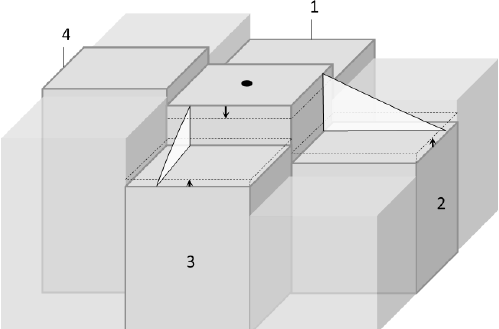
Figure 6. Schematic of the sediment distribution technique used to distribute sediment to cells with lower elevations. In the example, the angle between the central cell and cells [2] and [3] exceeds the threshold for diffusion. Sediment is removed from the central cell and redistributed to these cells. Cells [1] and [4] are not readjusted in this iteration but may be in subsequent sweeps of the